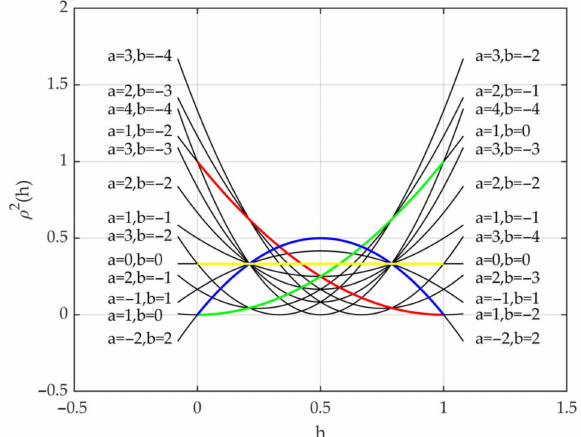
Figure 14. The squares of the parabola equations with different integer feasible solutions, which correspond to the cross symbols in Figure 13. The yellow, green, red and blue represent the square of the cylinder, cone, inverted cone and ellipsoid equations, respectively, and correspond to the bold dots in Figure